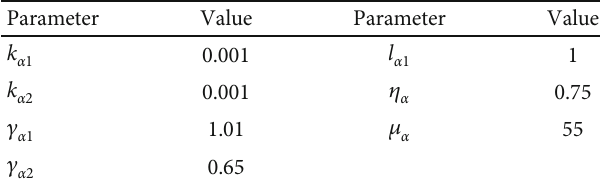
Table 3: Parameters of the angle of attack controller.